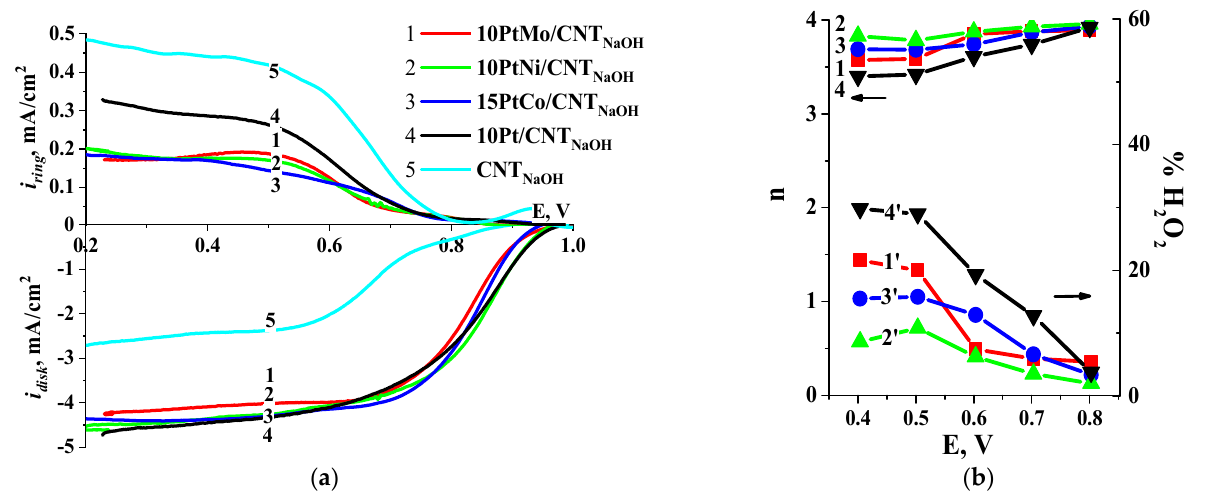
Figure 6. ( a ) Reduction polarization curves of O 2 on a disk electrode and their corresponding HO 2 − oxidation curves on the ring electrode, 0.1 M KOH, 100 mcg/cm 2 , 5 mV/s, 1500 rpm, E ring =1.2 V; ( b ) Dependence of the number of electrons (n) involved in the reaction (1, 2, 3, 4) and yield of hydrogen peroxide (1 ′ , 2 ′ , 3 ′ , 4 ′ ) on the electrode potential.